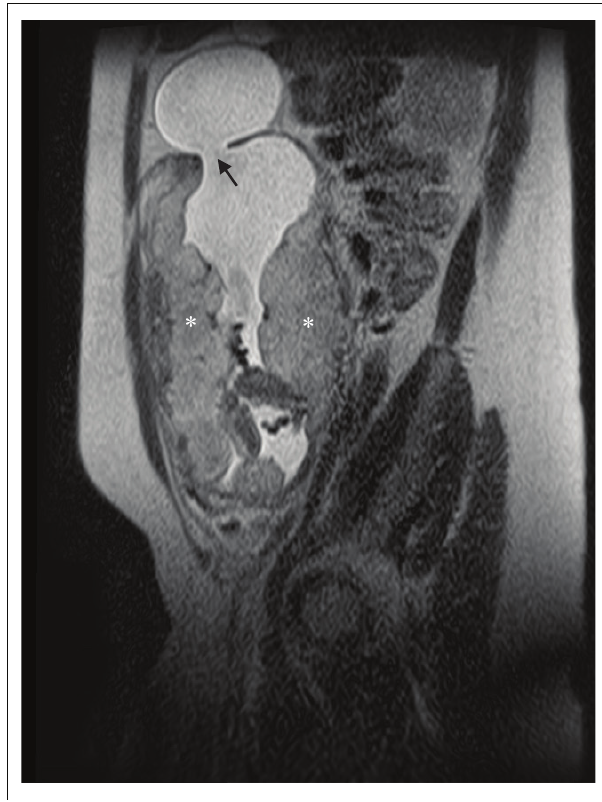
FIGURE 3: Sagittal T2-weighted magnetic resonance imaging demonstrating a defect in the myometrium of the uterine fundus through which part of the amniotic sac has herniated (arrow). Placental tissue could be seen lining the anterior and posterior uterine walls, and extending to the fundus anteriorly (asterisks).